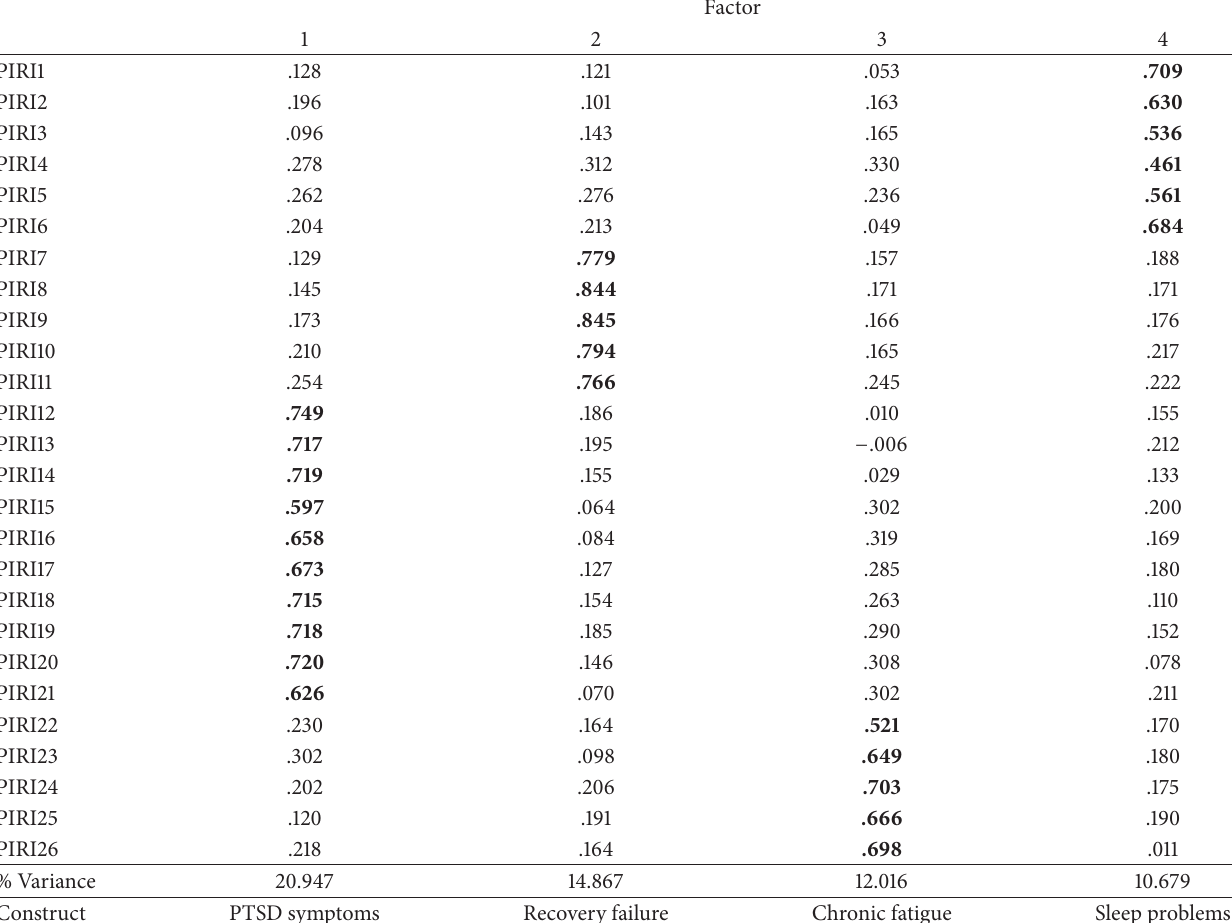
Table 3: Rotated matrix of components, 4-factor solution. Items correlated with the specific factor are evidenced in